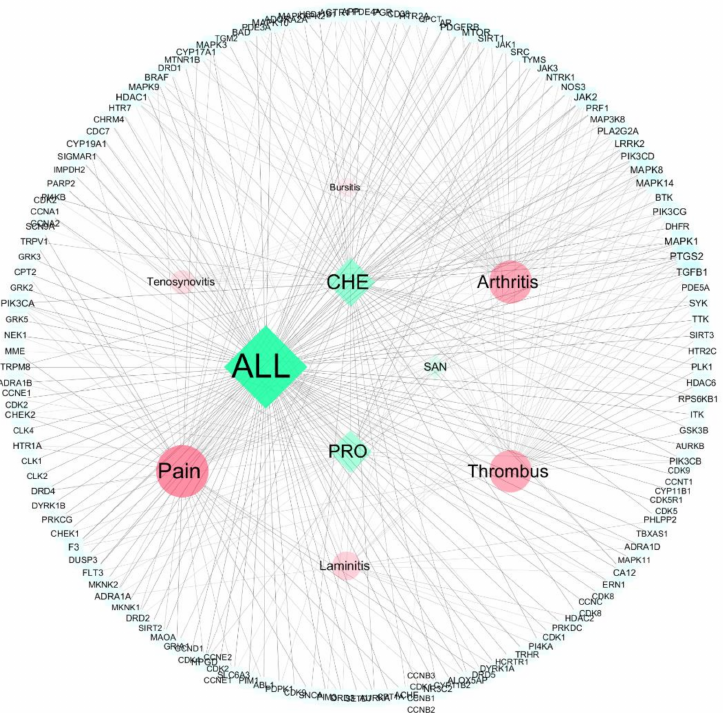
Figure 4. Compound − target − hoe disease network diagram (green diamonds for compounds, red circles for diseases, blue squares for targets).